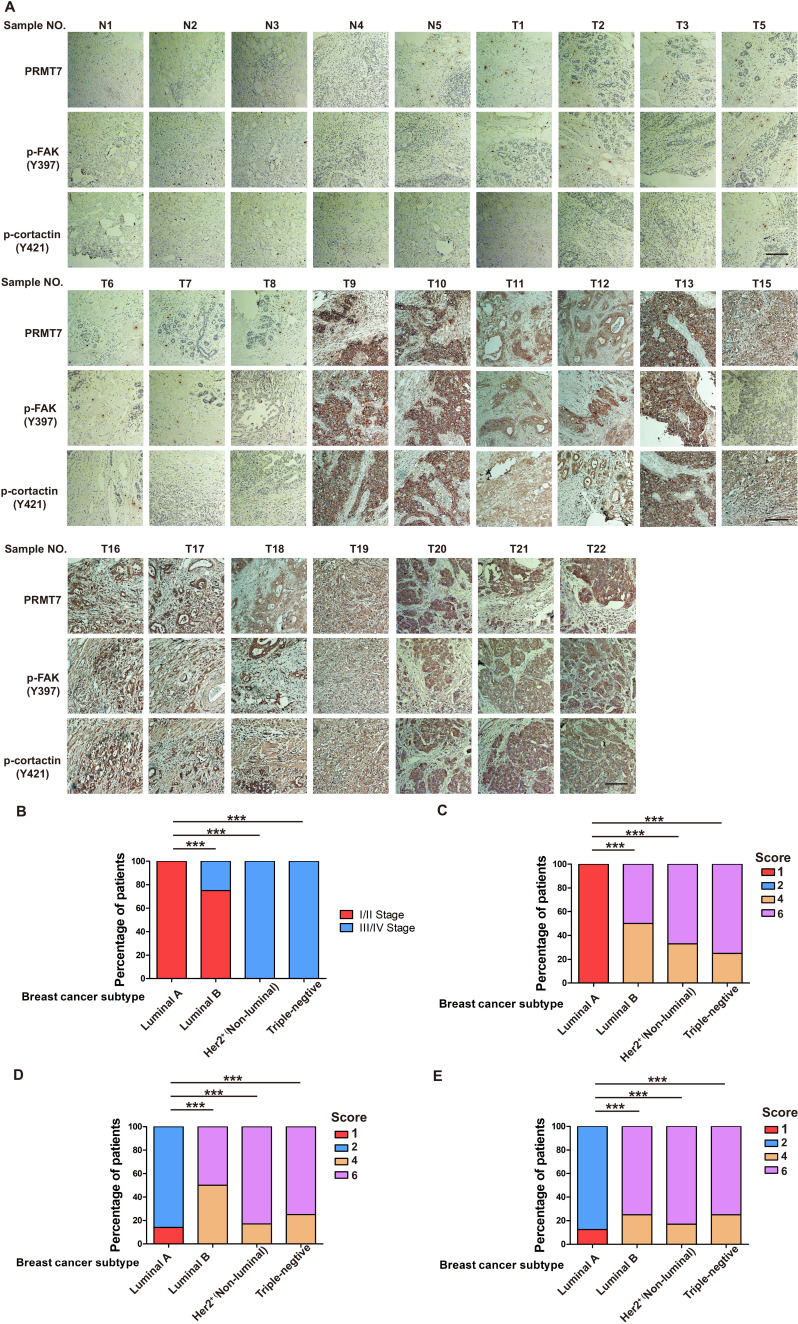
PRMT7 was associated with III stage breast cancer.(A) Typical pictures of the immunohistochemical staining of PRMT7, p-FAK and p-cortactin in breast cancer samples. Scale bars,100 µm. (B–E) Statistic of stage and staining correlates with subtype. n = 27, ***p<0.001, Chi2 test.